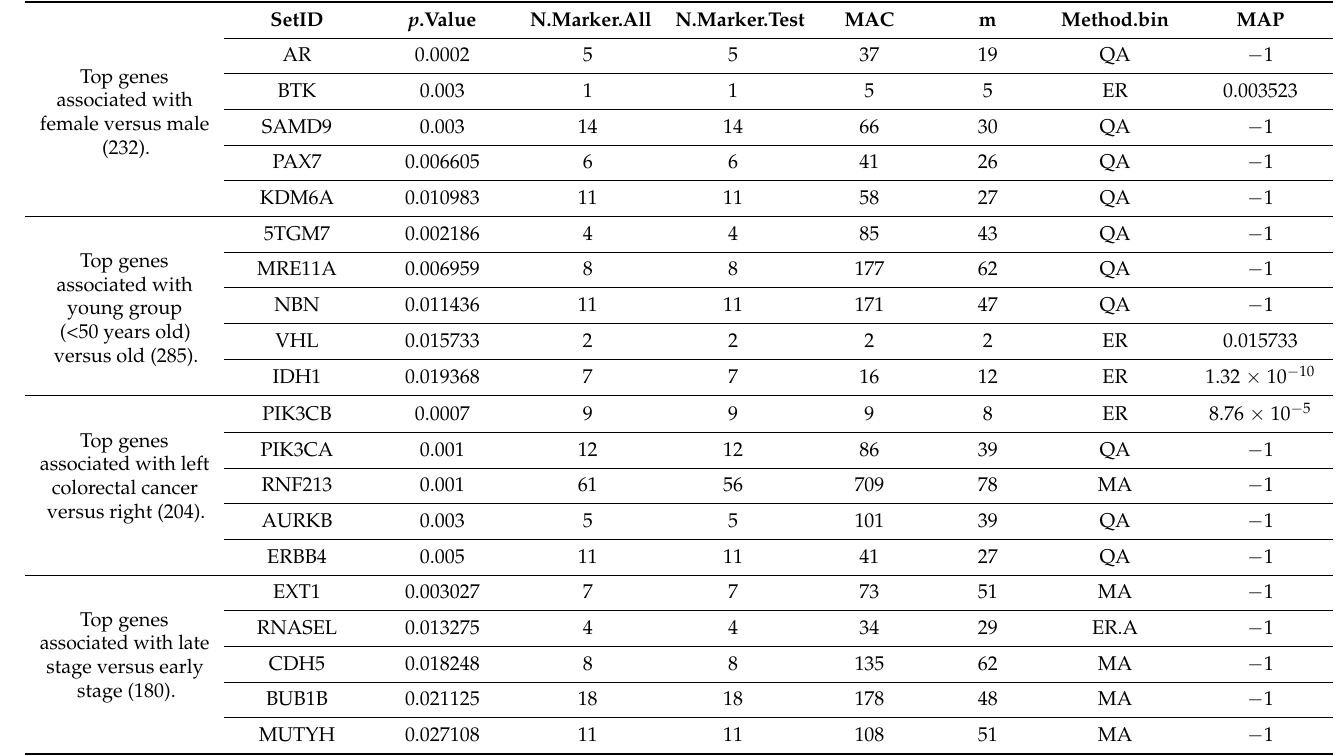
Table 3. Association of mutated genes with